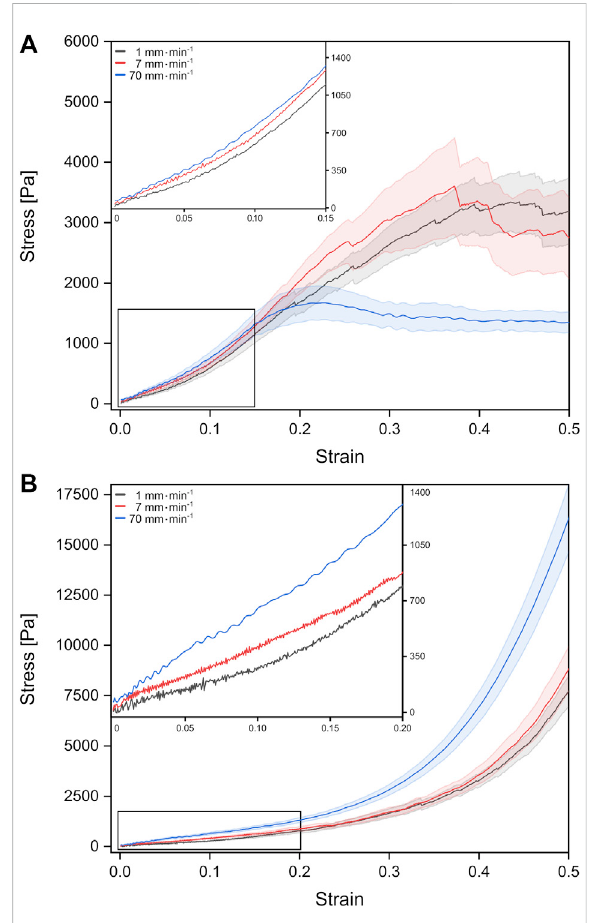
FIGURE 2 Stress-strain behavior of fetal rat lung tissue samples under tension (A) and compression (B) . The different curves represent mean values with the standard error obtained from individual tests with different probing velocities represented by colors (stress-strain data from individual test can be found in the Supplementary Figures S1,